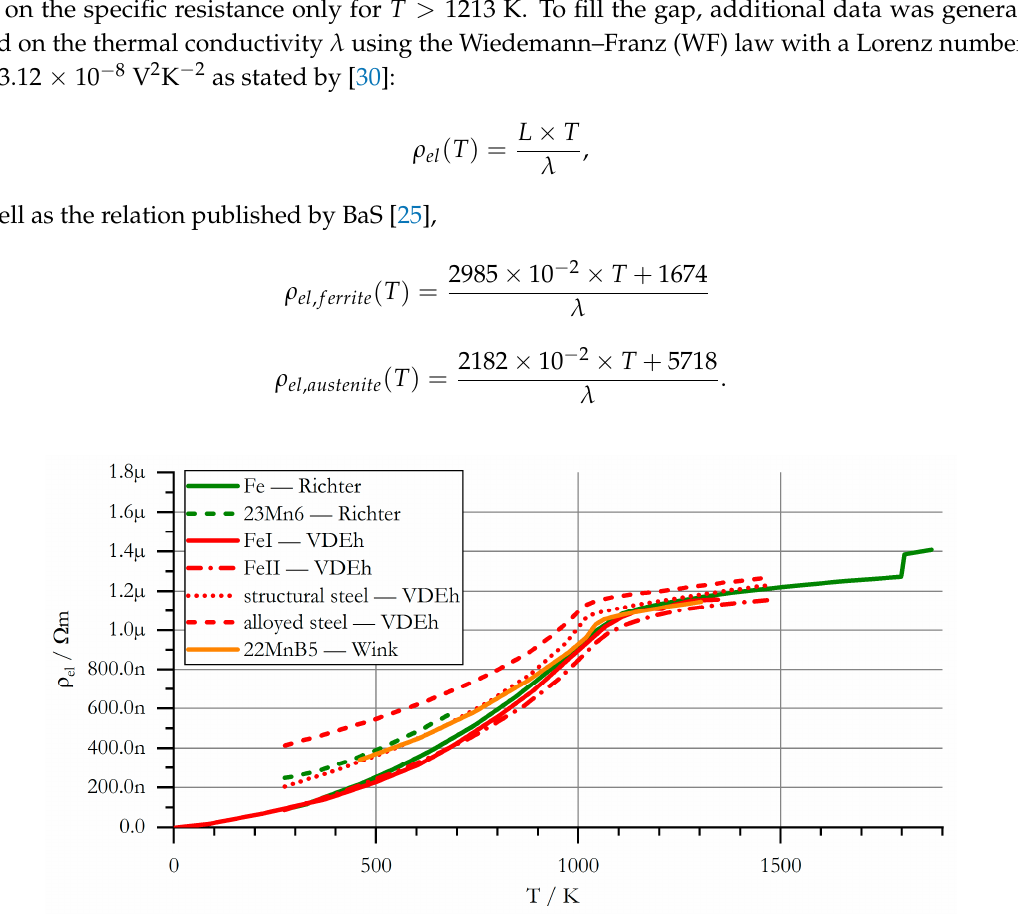
Figure 7. Coefficient of thermal expansion of 22MnB5.